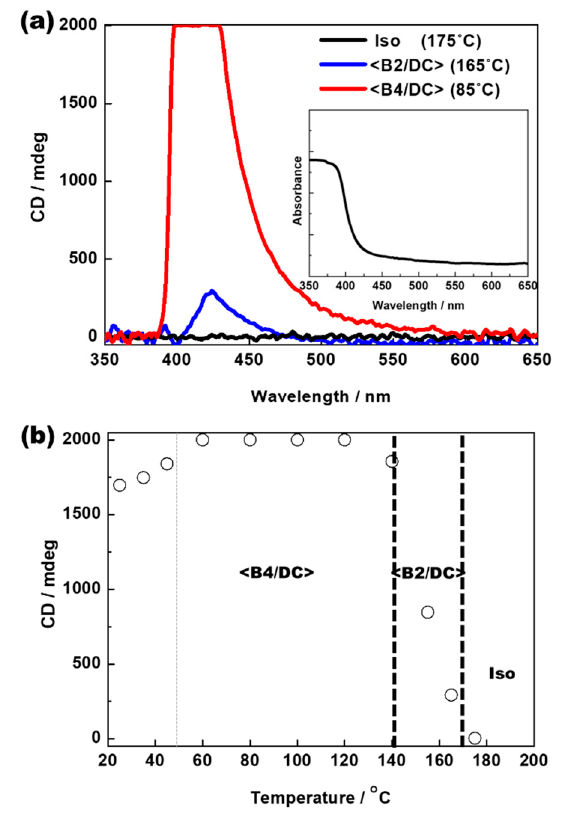
Figure 5. ( a ) Typical induced CD spectra from positive enantiomeric domains in Iso, <B2/DC>, and <B4/DC> in a binary mixture consisting of 70 wt% BC molecule and 30 wt% BCMP (inset: absorbance spectrum of binary mixture) and ( b ) maximum CD peak intensity of positive domain at approximately 415 nm as a function of temperature.